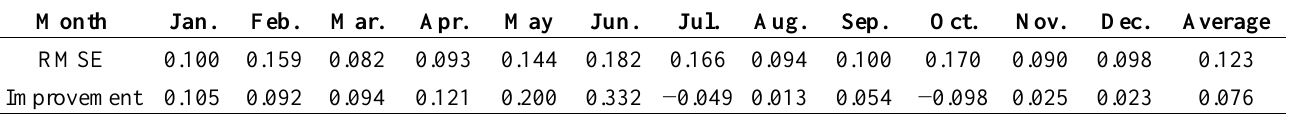
Table 7. RMSE improvements of monthly sea ice concentration in 2012 using the ARIMA models calibrated by the time series for each pixel. The improvements were calculated by subtracting the RMSE of ARIMA model from that of OLS model in Table 4. The values for the entire pixels were